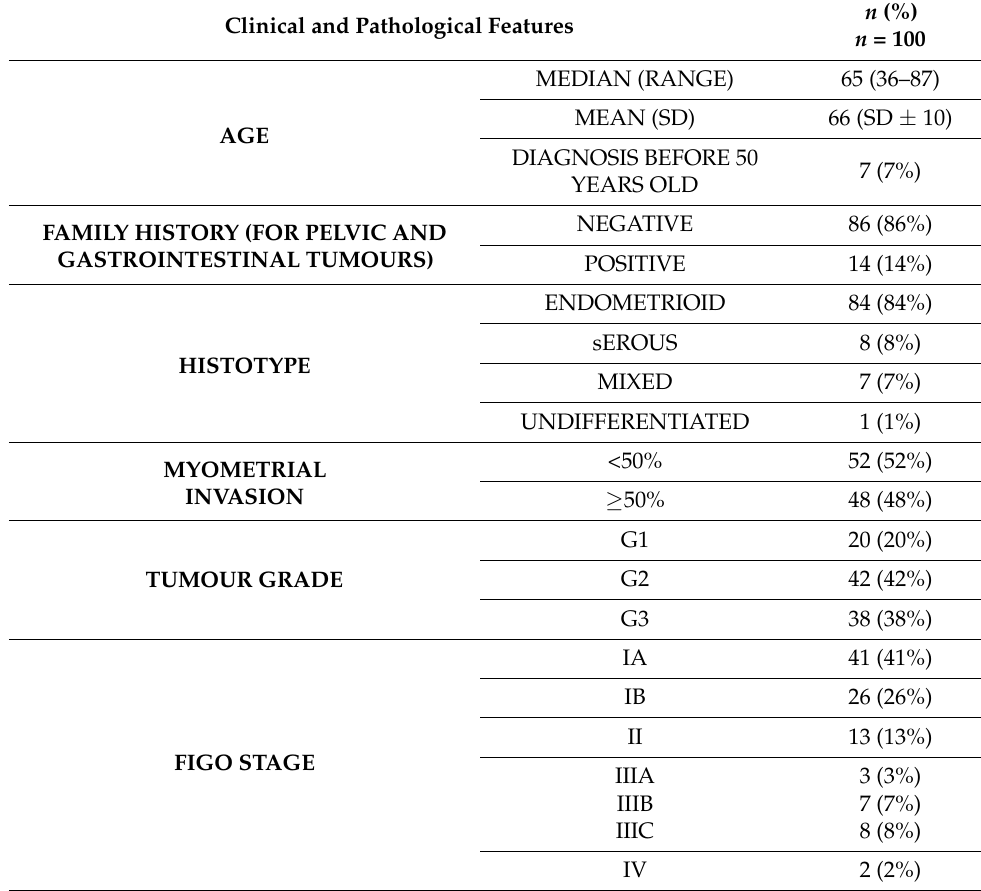
Table 1. Clinical and pathological features of the study population. Clinical and Pathological